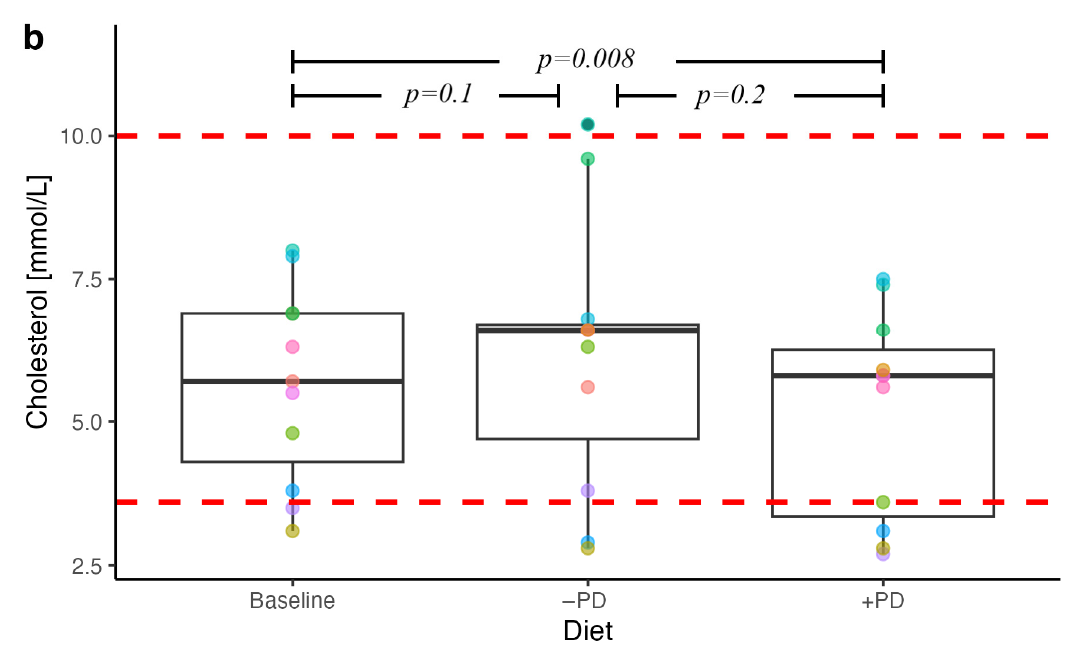
Figure 3. Serum lipid concentrations in privately owned healthy adult dogs (n = 11) fed a commercial diet with (+PD) or without ( − PD) Enterococcus faecium NCIMB 10415 10 9 CFU/kg for 16 days each in a crossover study design compared to baseline concentrations. Each dot colour on the plot identifies the individual dog across diets. Red dotted lines represent laboratory reference ranges. p values < 0.05 were considered significant.